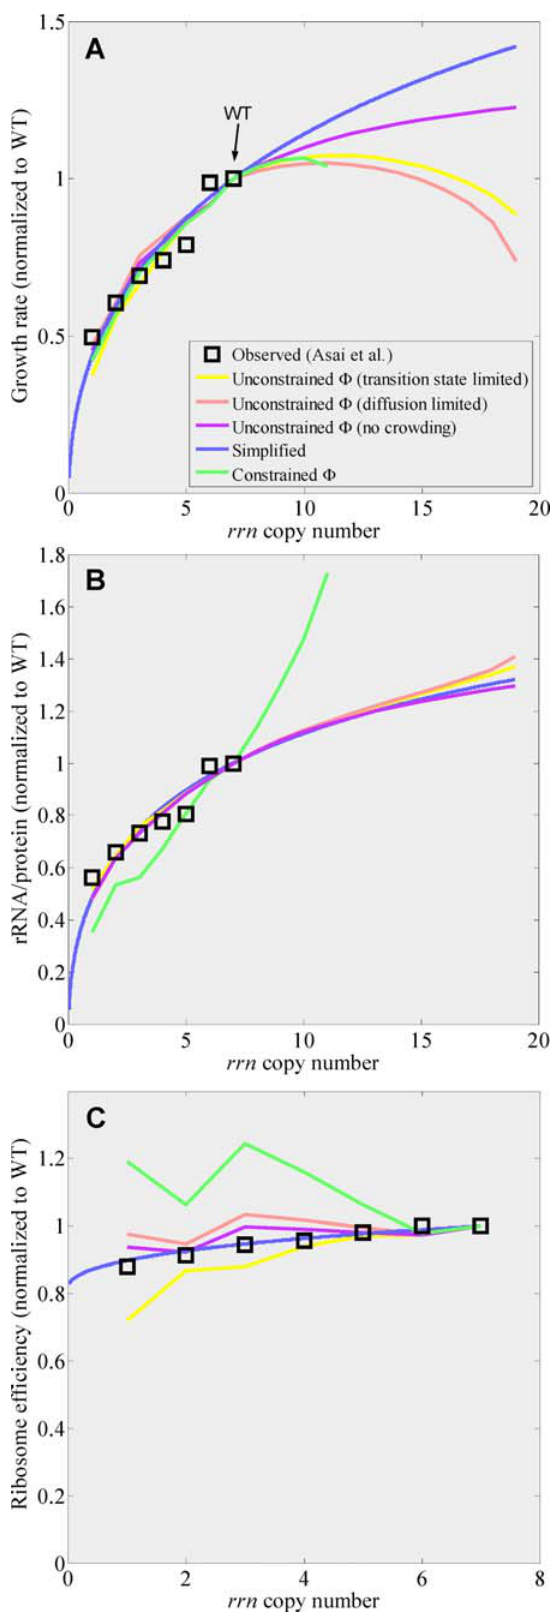
Figure 2. Comparison of rRNA operon inactivation data of Asai et al. [ 19 ] to CGGR models and predictions for higher rRNA operon copy numbers. (A) Growth rate as a function of rRNA operon copy number per chromosome. The maximum standard error of growth rate measurements was 0.07 [19]. (B) rRNA to total protein ratio, where total protein is given by total amino acids in the form of r-proteins and bulk proteins. Measurement error was not available for this data. In the case of the constrained model, solutions were not obtainable above a copy number 11. (C) Ribosome efficiency, defined as e r = a ? P/N ribo [3,19] (see text), was obtained by dividing the growth rate in (A) by the ratio of rRNA to total protein in (B). All curves are normalized to WT values at 2.0 doub/h. The legend to all figures is given in (A). The kink observed for copy number 2 is due to strong expression of lacZ in this strain used for inactivation. Beyond the WT rRNA gene dosage, rRNA operons were added at the origin (also see S1.4 in Text S1). The rRNA chain elongation rate, c rrn , was assumed to be fixed in these